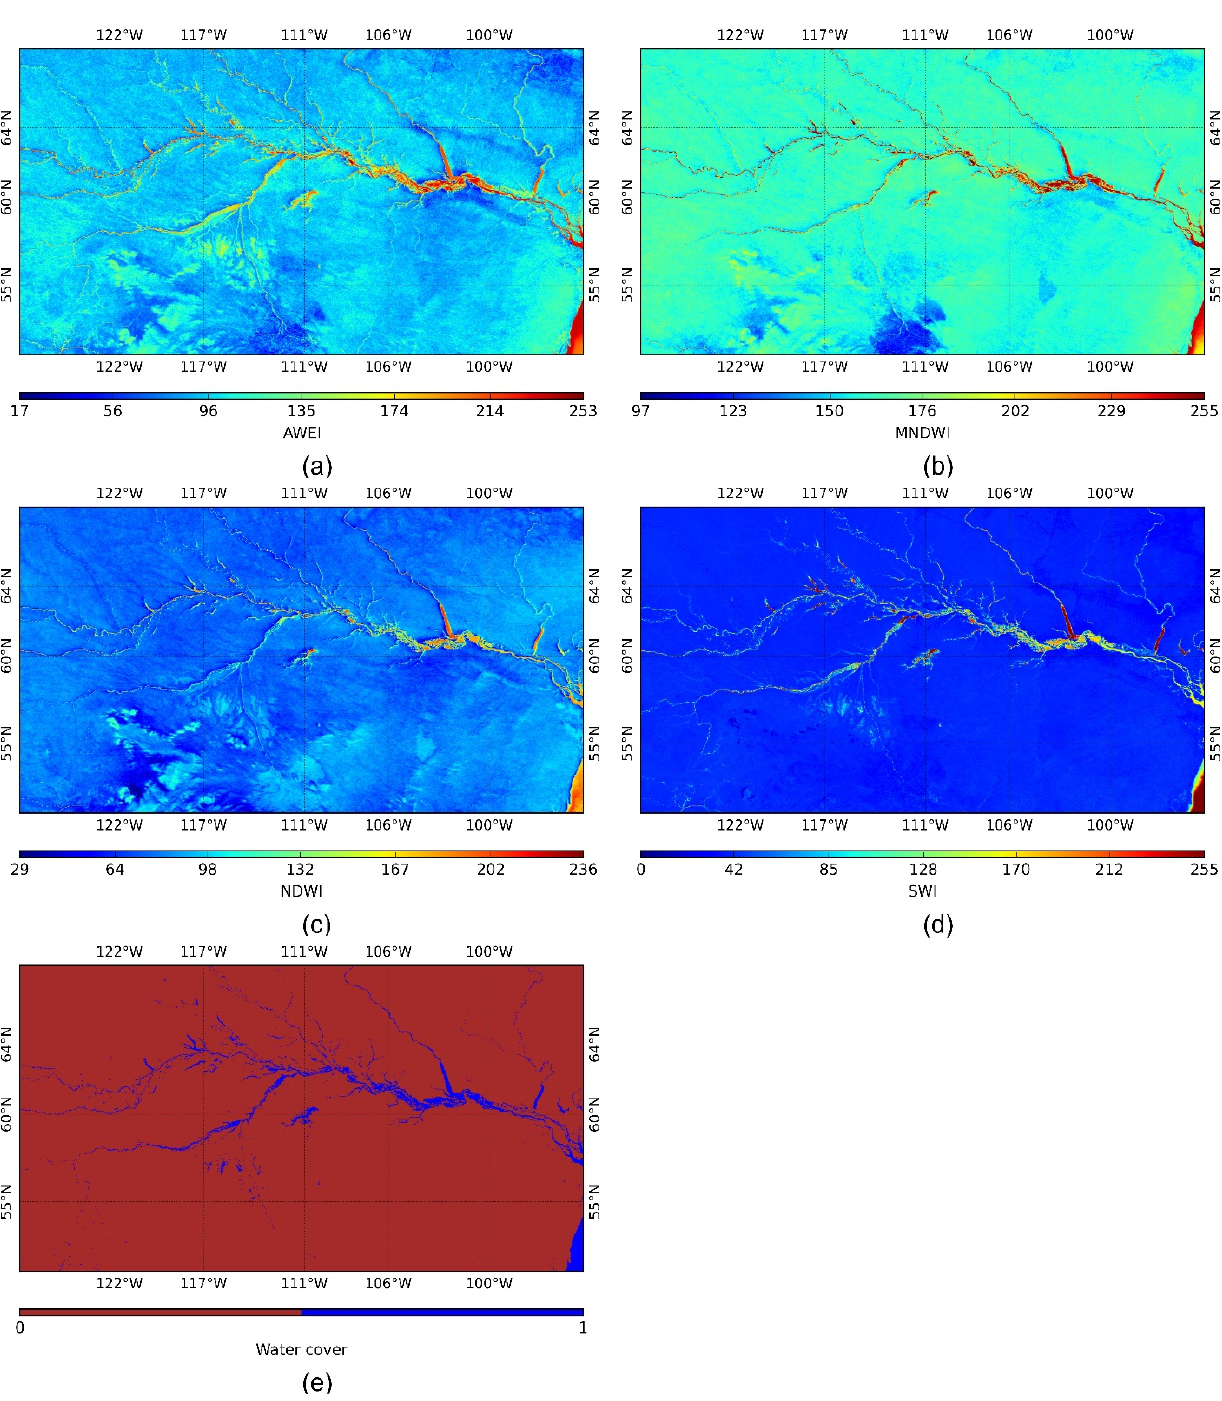
Figure 9. Plotting of four water indices and water cover map in a wet region: ( a ) Automated Water Extraction Index (AWEI), ( b ) Modified Normalized Difference Water Index (MNDWI), ( c ) Normalized Difference Water Index (NDWI), ( d ) Superfine Water Index (SWI), ( e ) Reference water cover